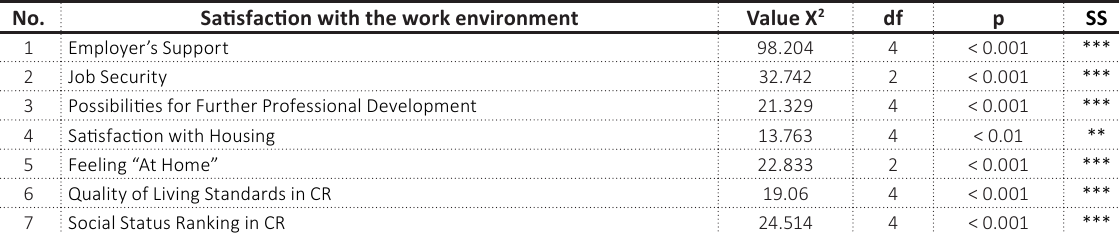
Table 4. Satisfaction with the work